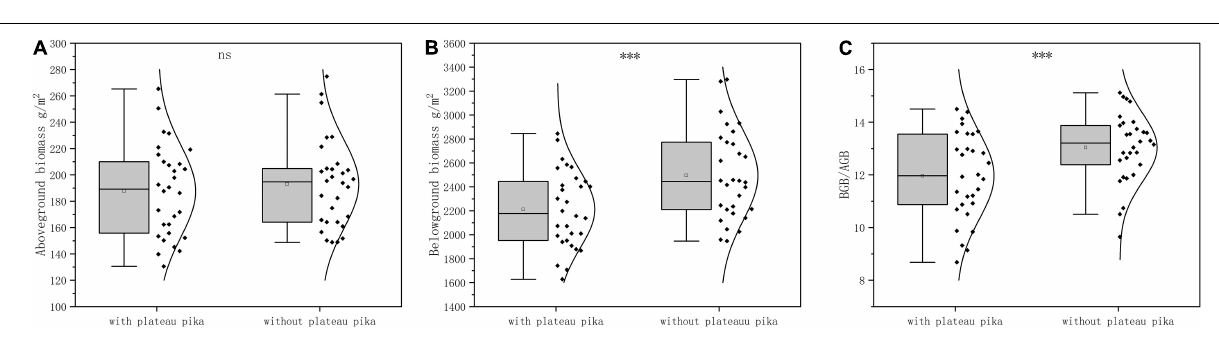
FIGURE 2 | The (A) plant AGB, (B) BGB, and (C) ratio of BGB and AGB in the presence and absence of plateau pikas across three sites. The statistics were from the linear mixed model, in which the three sites (site) and disturbance by plateau pikas (Dist.) were fixed effects, and paired plots nested within the site were a random effect. The quadrilateral points in the box represent the average of variables in the presence and absence of plateau pikas. ∗ Significant differences at p < 0.05, ∗∗ p < 0.01, ∗∗∗ p < 0.001, ns p >